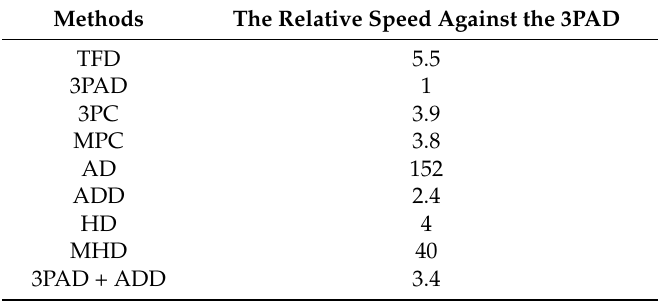
Table 2. The speed of the computation for the different filters compared against the fastest, the 3PAD